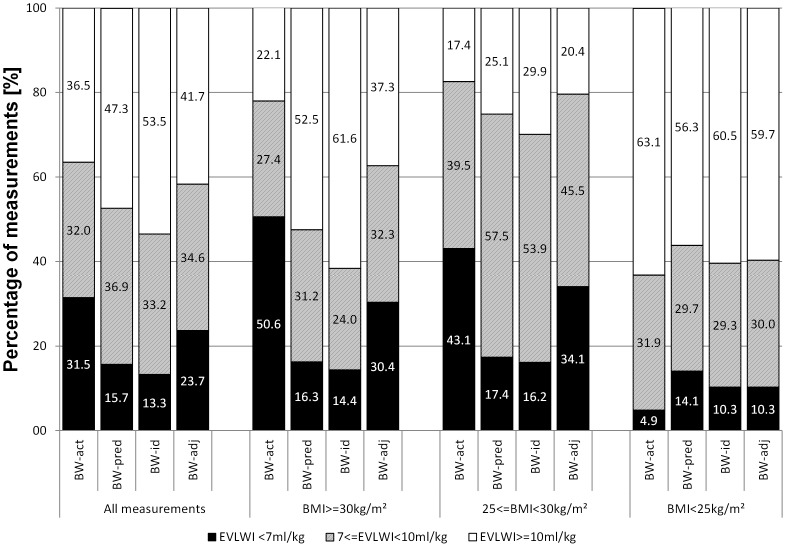
Distribution of measurements classified as “normal” (EVLWI<7 mL/kg), “moderately elevated” (7≤EVLWI<10 mL/kg) and “markedly elevated” (EVLWI≥10 mL/kg) depending on the indexation of EVLWI according to weight-based indexations to BWact, BWpred, BWid and BWadj.Numbers in the columns indicate the percentage of measurements within this classification (*p<0.05 and ** p<0.001 vs. percentage of normal measurements of EVLWIact<7 mL/kg within the same BMI-category).